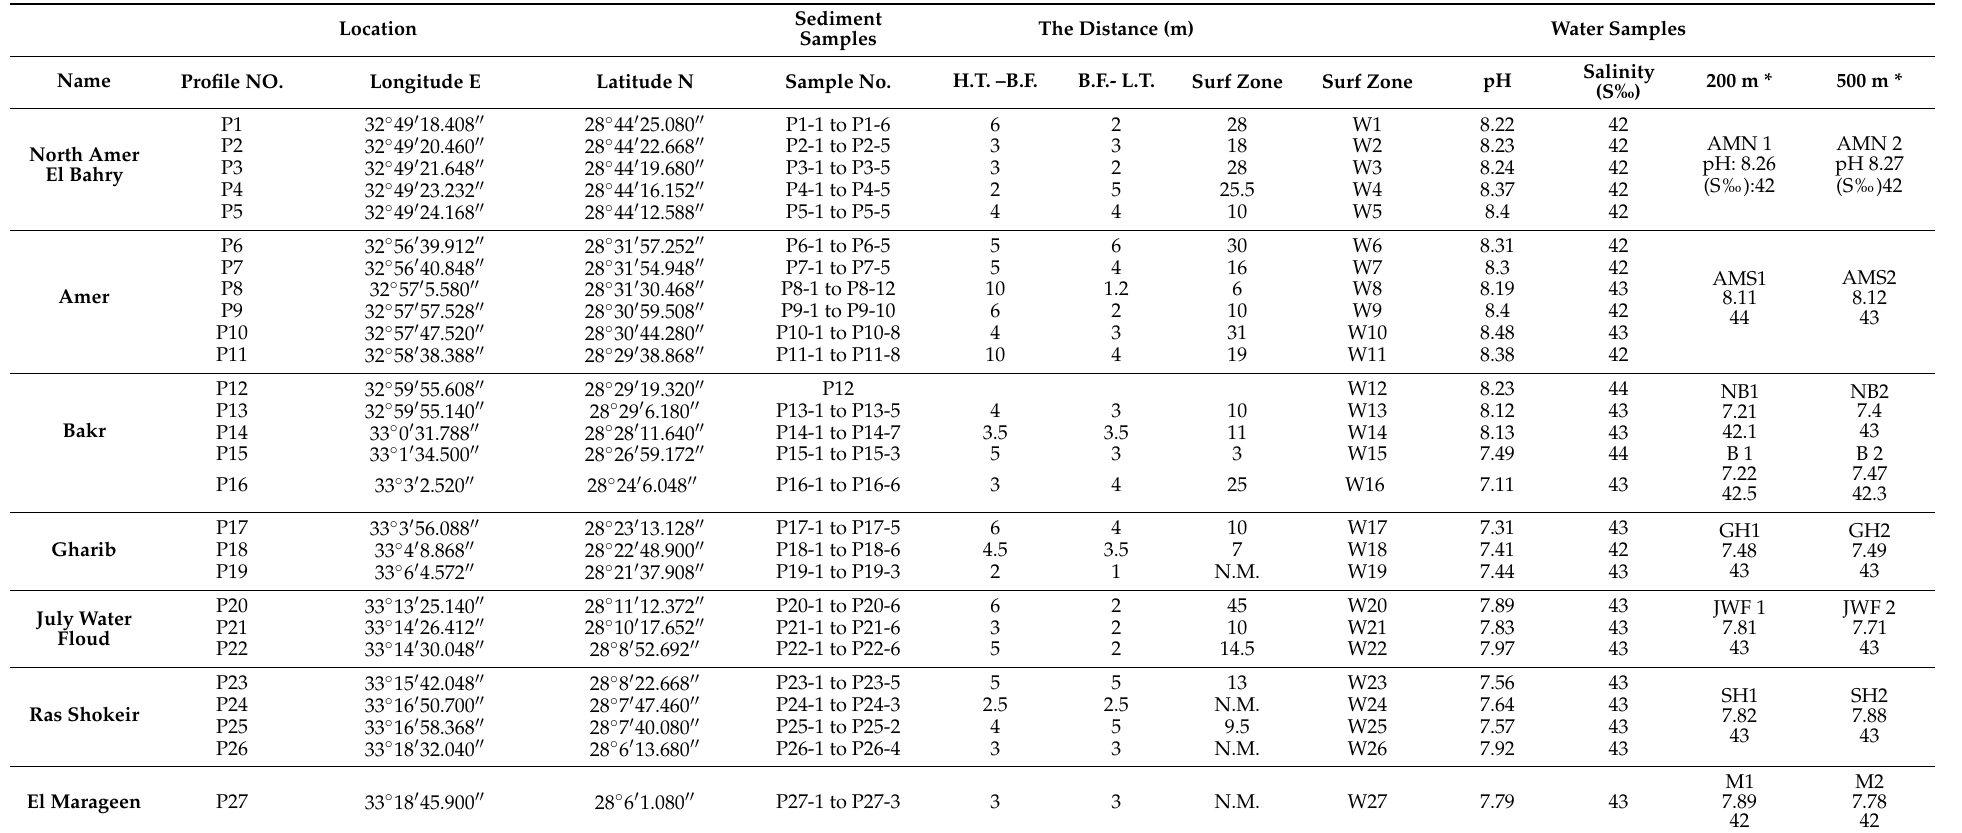
Table 1. Field measurements, sampling, and hydrochemical